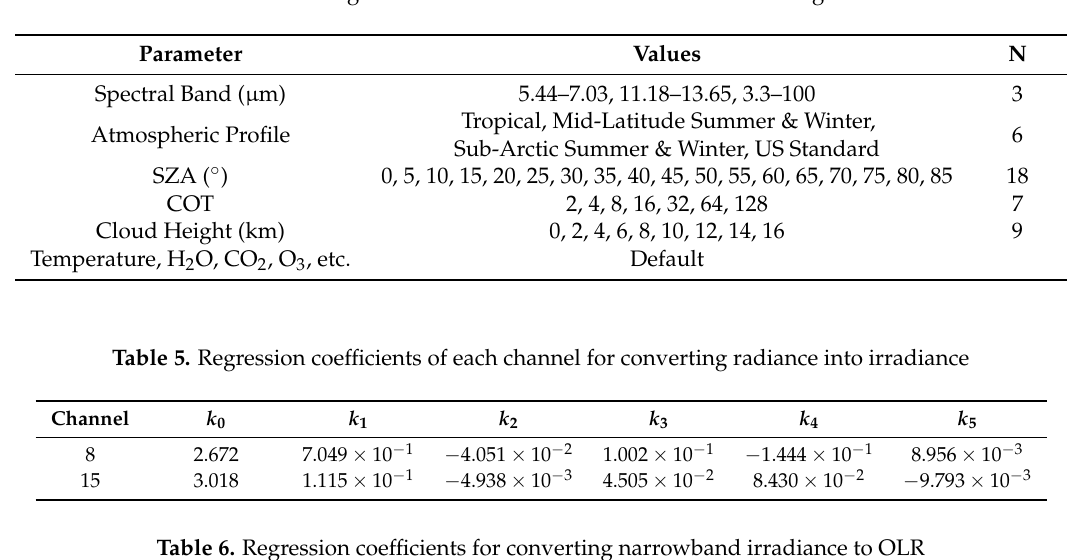
Table 6. Regression coefficients for converting narrowband irradiance to OLR d 0 d